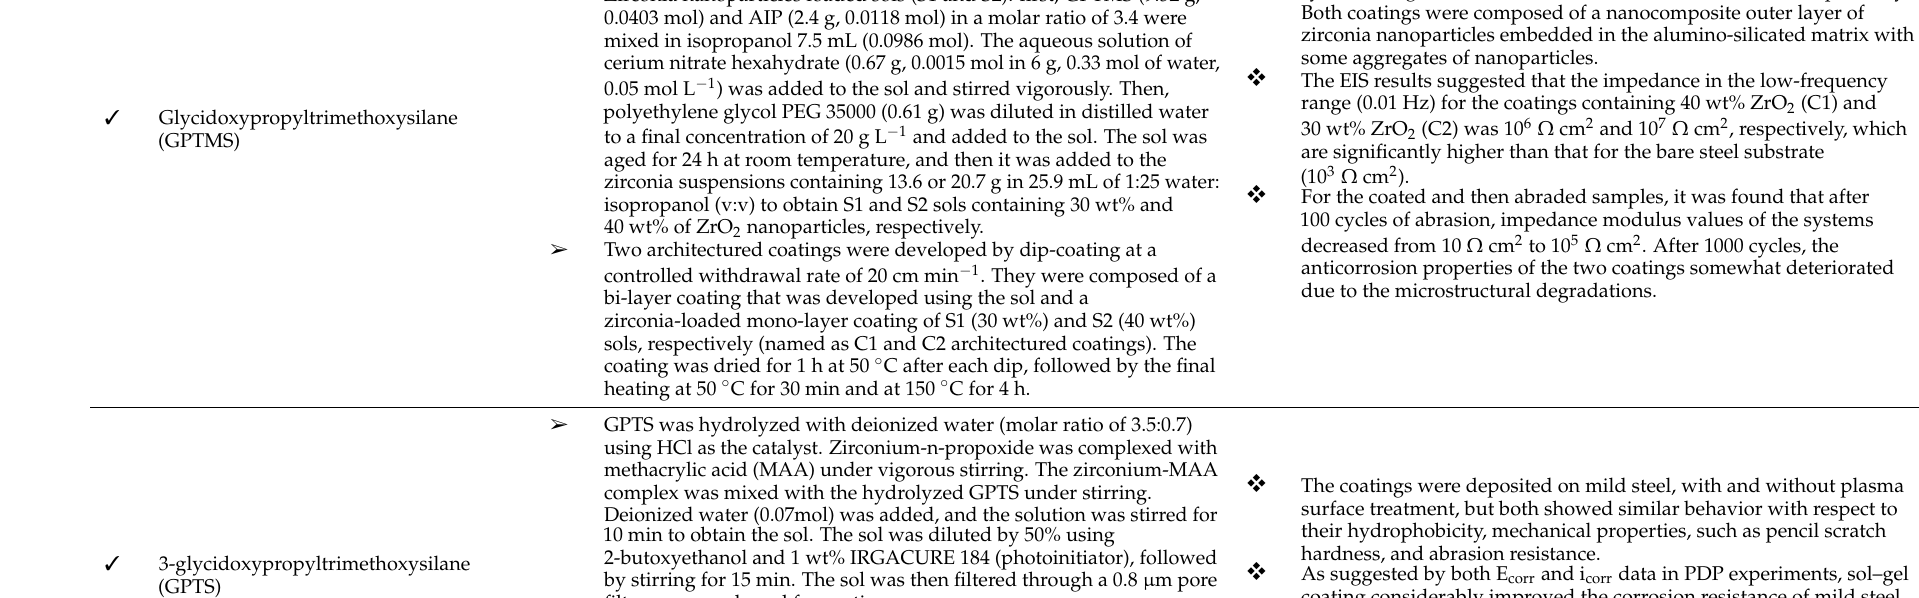
Table 1. Different approaches for improving silane coatings and the main findings, as reported in the literature. Coating Preparation Main Findings Ref.